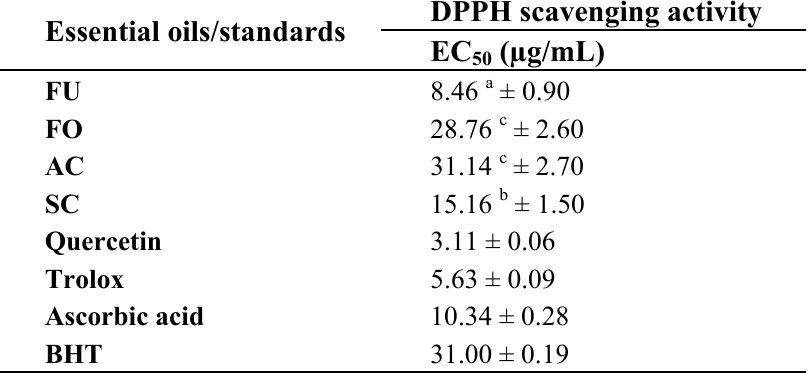
Table 3. Antioxidant activity of essential oils of H. gardnerianum collected at different locations. Essential oils/standards